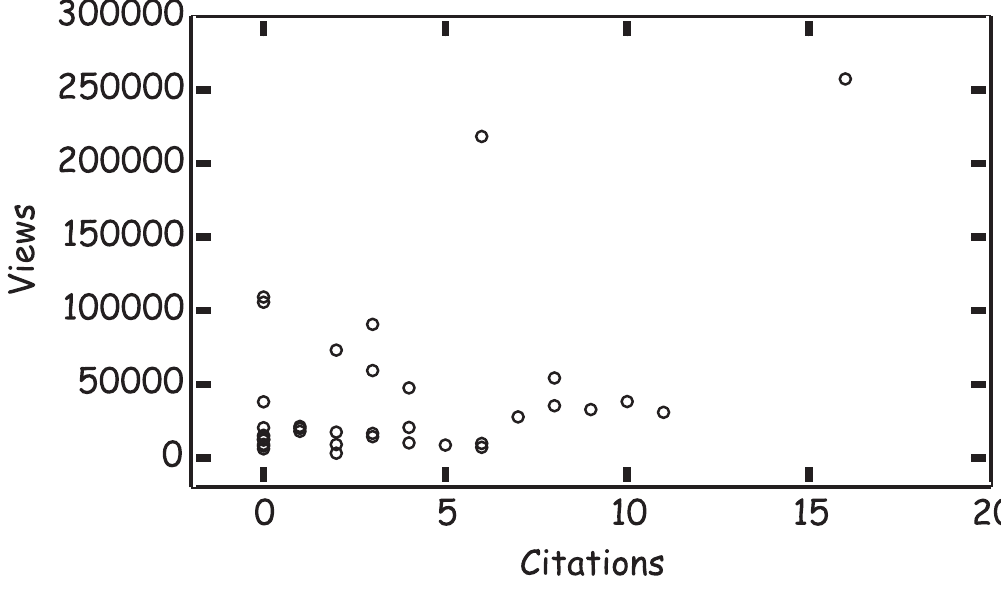
Figure 3. Ten Simple Rules articles are viewed more often than they are cited.